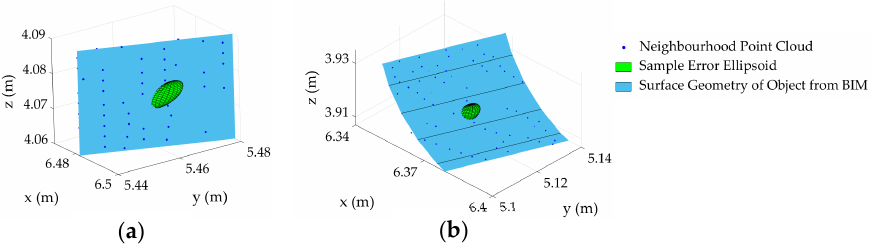
Figure 3. Schematic intersection of a sample ellipsoid with a 3D model: ( a ) planar surface and ( b ) cylindrical surface.